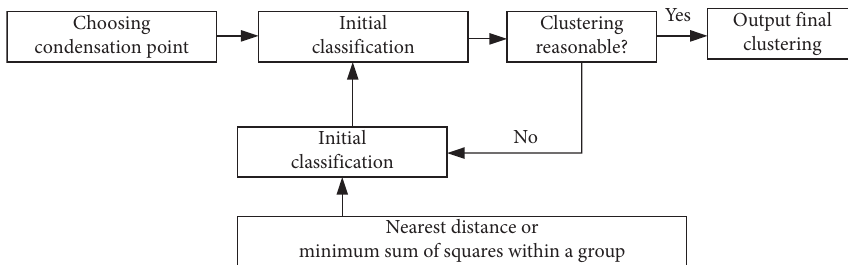
Figure 4: Dynamic clustering computing process [23].